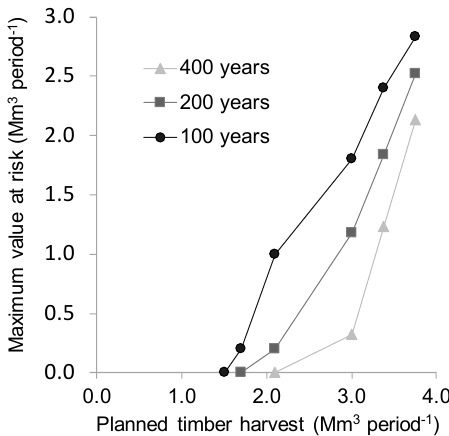
Figure 5. Relationship between planned timber harvest and maximum value at risk for three fire cycles.